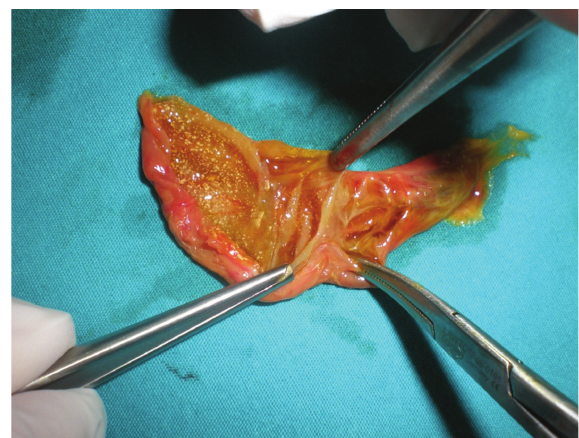
Figure 3: Macroscopic examination demonstrates multiple edema- tous septa dividing the gallbladder lumen into